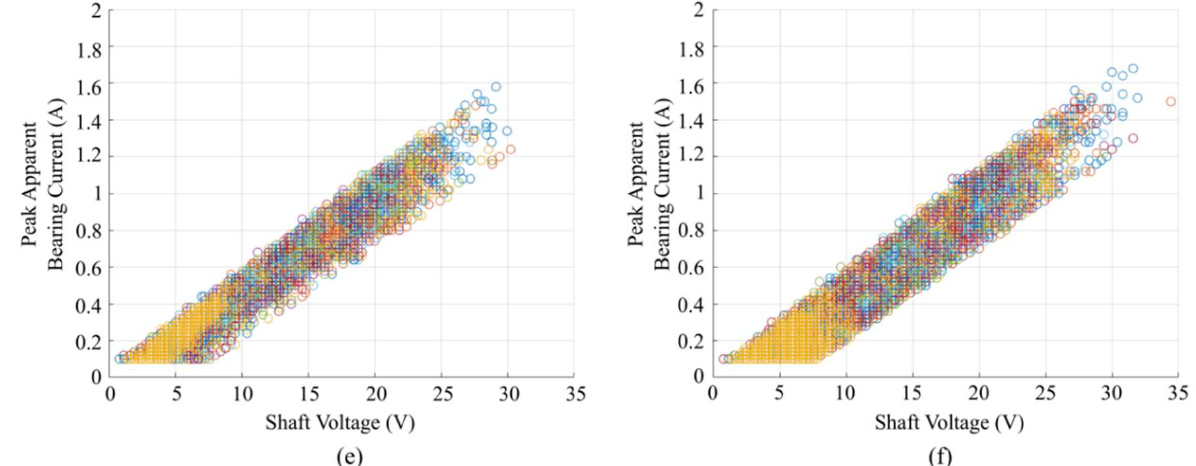
Figure 13. Shaft discharge voltage and peak apparent bearing current data for various bearing operational temperatures: 3D plots for ( a ) Si and ( b ) SiC inverters. 2D plots comparing shaft discharge voltages against operational temperature for ( c ) Si and ( d ) SiC inverters, and 2D plots displaying the peak apparent bearing currents for a given shaft breakdown voltage for ( e ) Si and ( f ) SiC inverters.